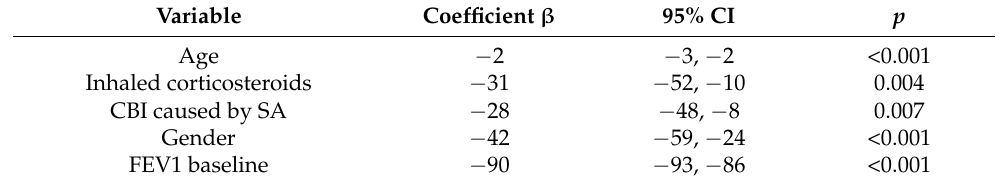
Figure 3. Decrease in FEV1% in the group of non-colonized patients (n = 349) ( p = 0.918) and patients with CBI caused by SA (n = 77) ( p < 0.001). FEV1: Forced expiratory volume one second; CI: confidence interval. Table 4. Factors associated with a more significant reduction in FEV1% in the total group of